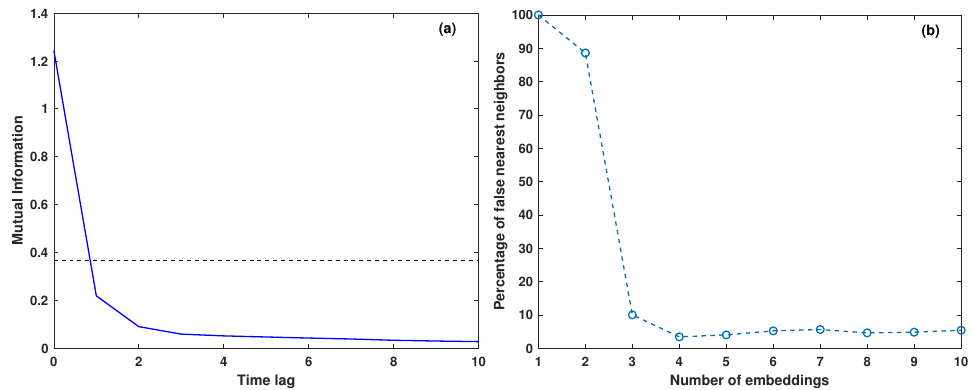
Figure 3. Plots of ( a ) average mutual information and ( b ) false nearest neighbors for PM 10 data. In ( a ) the black horizontal dashed line indicates the default threshold